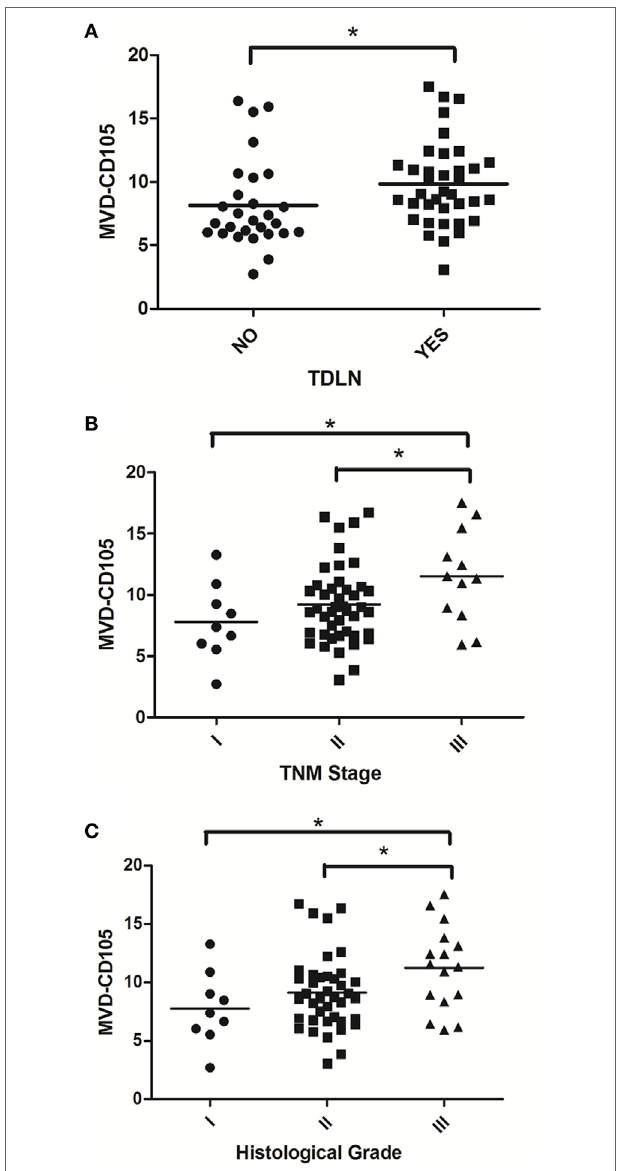
FigUre 3 | Scatter plot of microvessel density (MVD)-CD105 level associated with TDLNs metastasis, TNM stage and histological grade. The MVD-CD105 level in breast cancer patients with lymph nodes metastasis was significantly higher than those without lymph node metastasis (a) . The MVD-CD105 level was higher in stage III breast cancer patients than stage I or stage II patients (B) . The MVD-CD105 level was higher in histological grade III breast cancer patients than histological grade I or histological grade II patients (c)